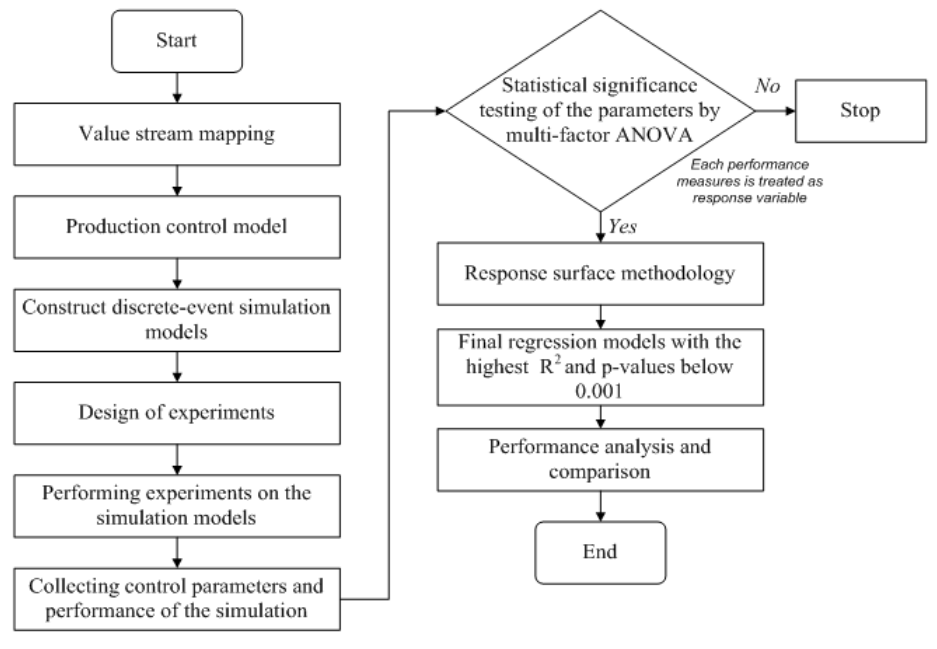
Figure 1. Flow chart of the research